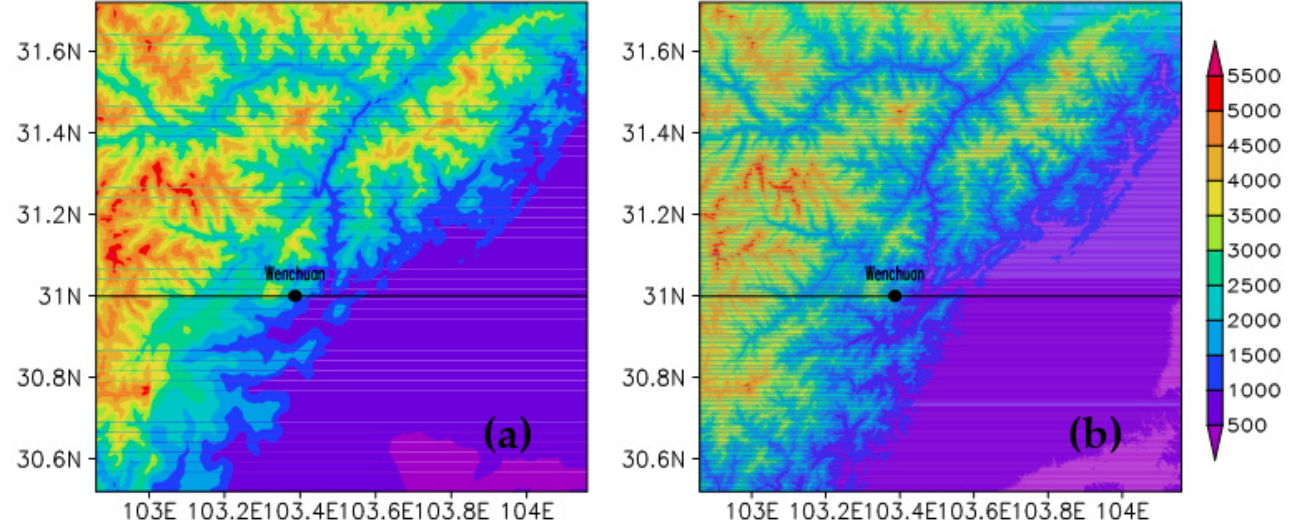
Figure 1. The topography distribution over the studied region in western Sichuan with ( a ) 30 ″ resolution and ( b ) 90 m resolution (shaded, unit: m). The position of Wenchuan County is plotted as a dot. Black line indicates the cross-section along 31° N.